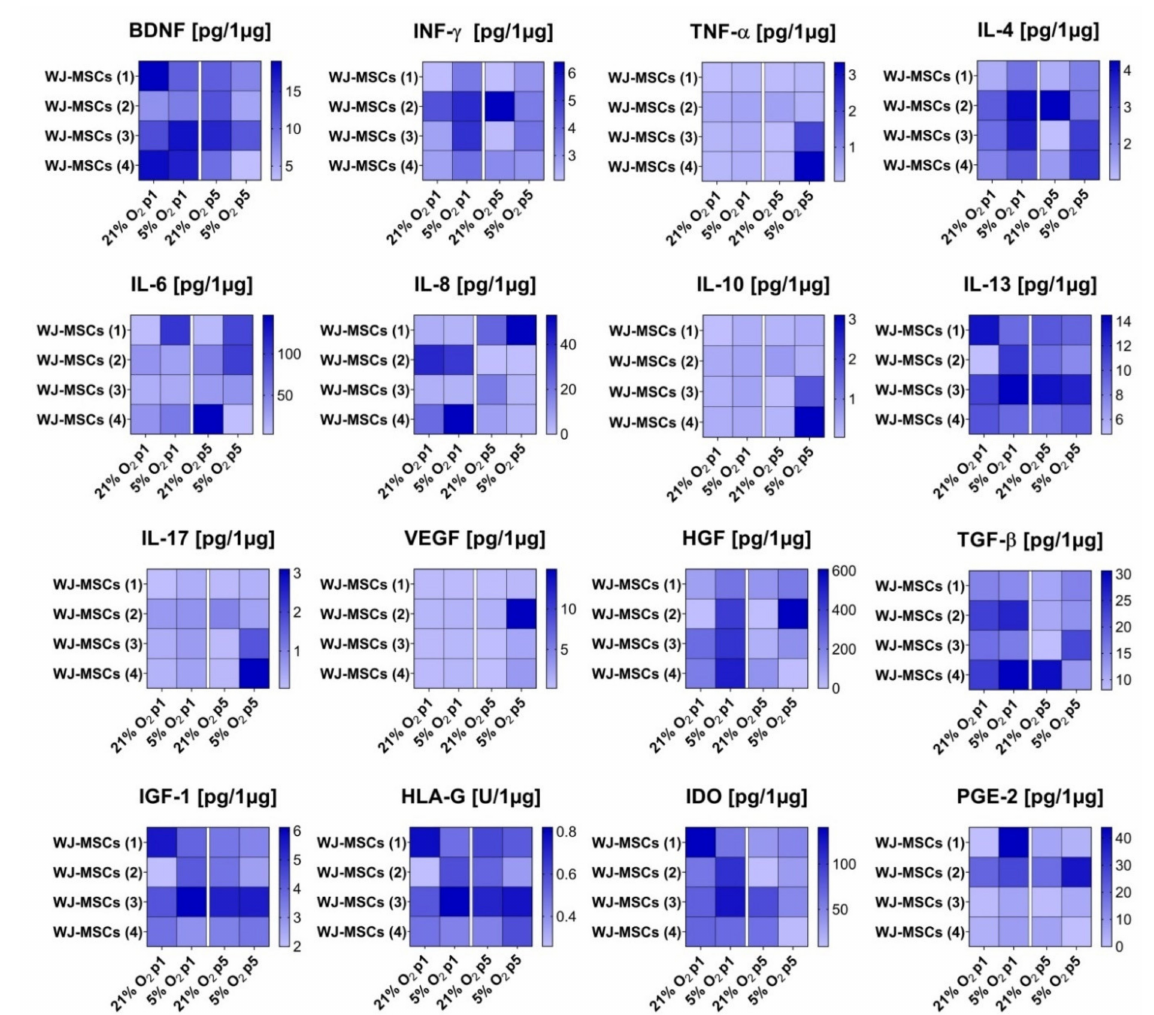
Figure 5. Secretory profile of hWJ-MSCs cultured under 21% O 2 and 5% O 2 (passages 1 and 5). The results are expressed as the mean for the individual donors ( n = 4). The colour scale illustrates the relative expression of the analysed